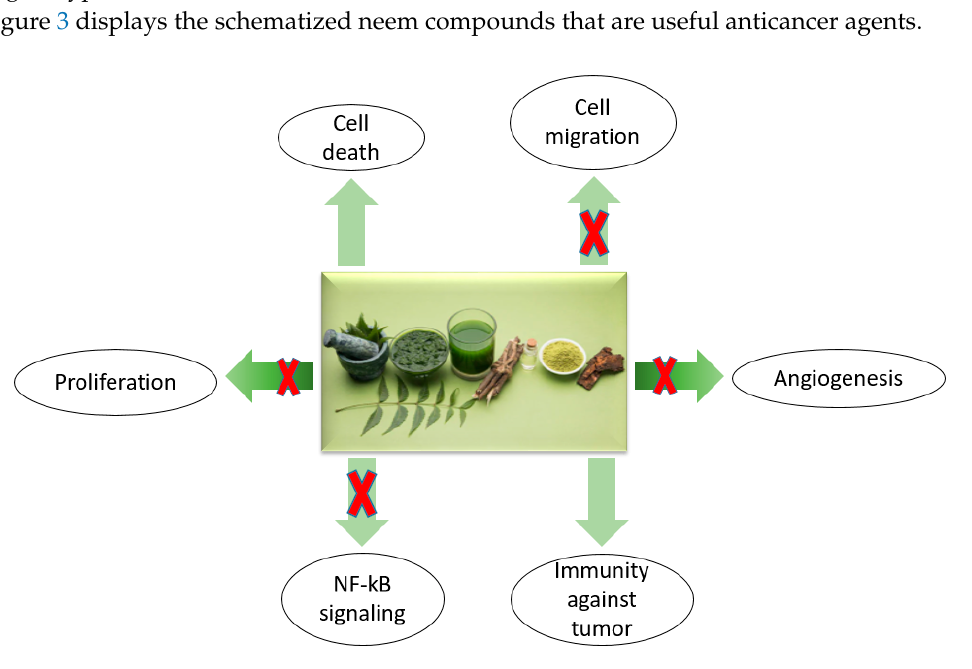
Figure 3. The schematization of neem components as anticancer agents. Their effects include angiogenesis suppression, antiproliferative effects, and suppression of NF- κ B. Also, bioactive compounds of neem increase transformed cell death and immunity surveillance (adapted from Hao [69]).